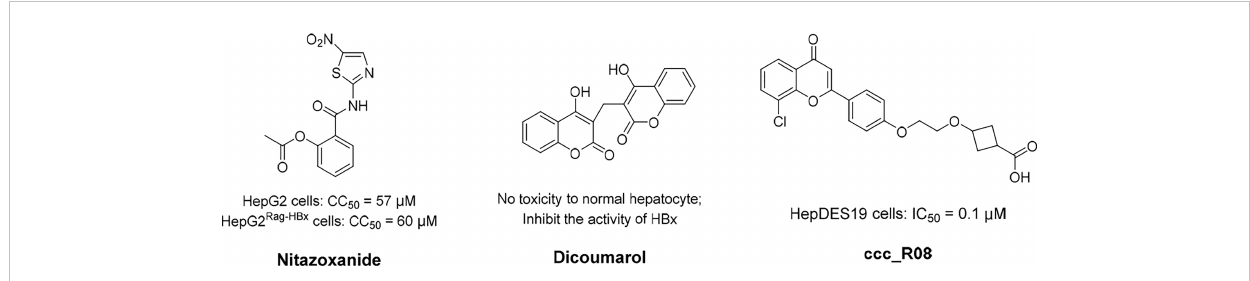
FIGURE 4 The structures of nitazoxanide, dicoumarol, and ccc_R08. Concentration for 50% of maximal effect (EC50), 50% cytotoxicity concentrations (CC50), the half maximal inhibitory concentration